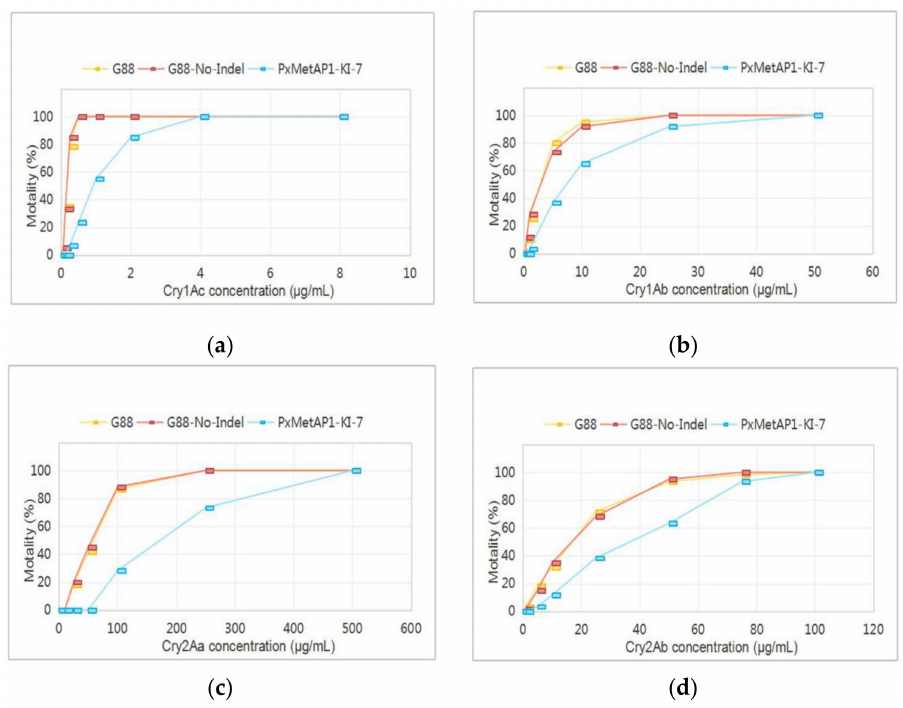
Figure 7. Reaction of different P. xylostella strains to Bt toxins. ( a ) Cry1Ac toxin; ( b ) Cry1Ab toxin; ( c ) Cry2Aa toxin; and ( d ) Cry2Ab